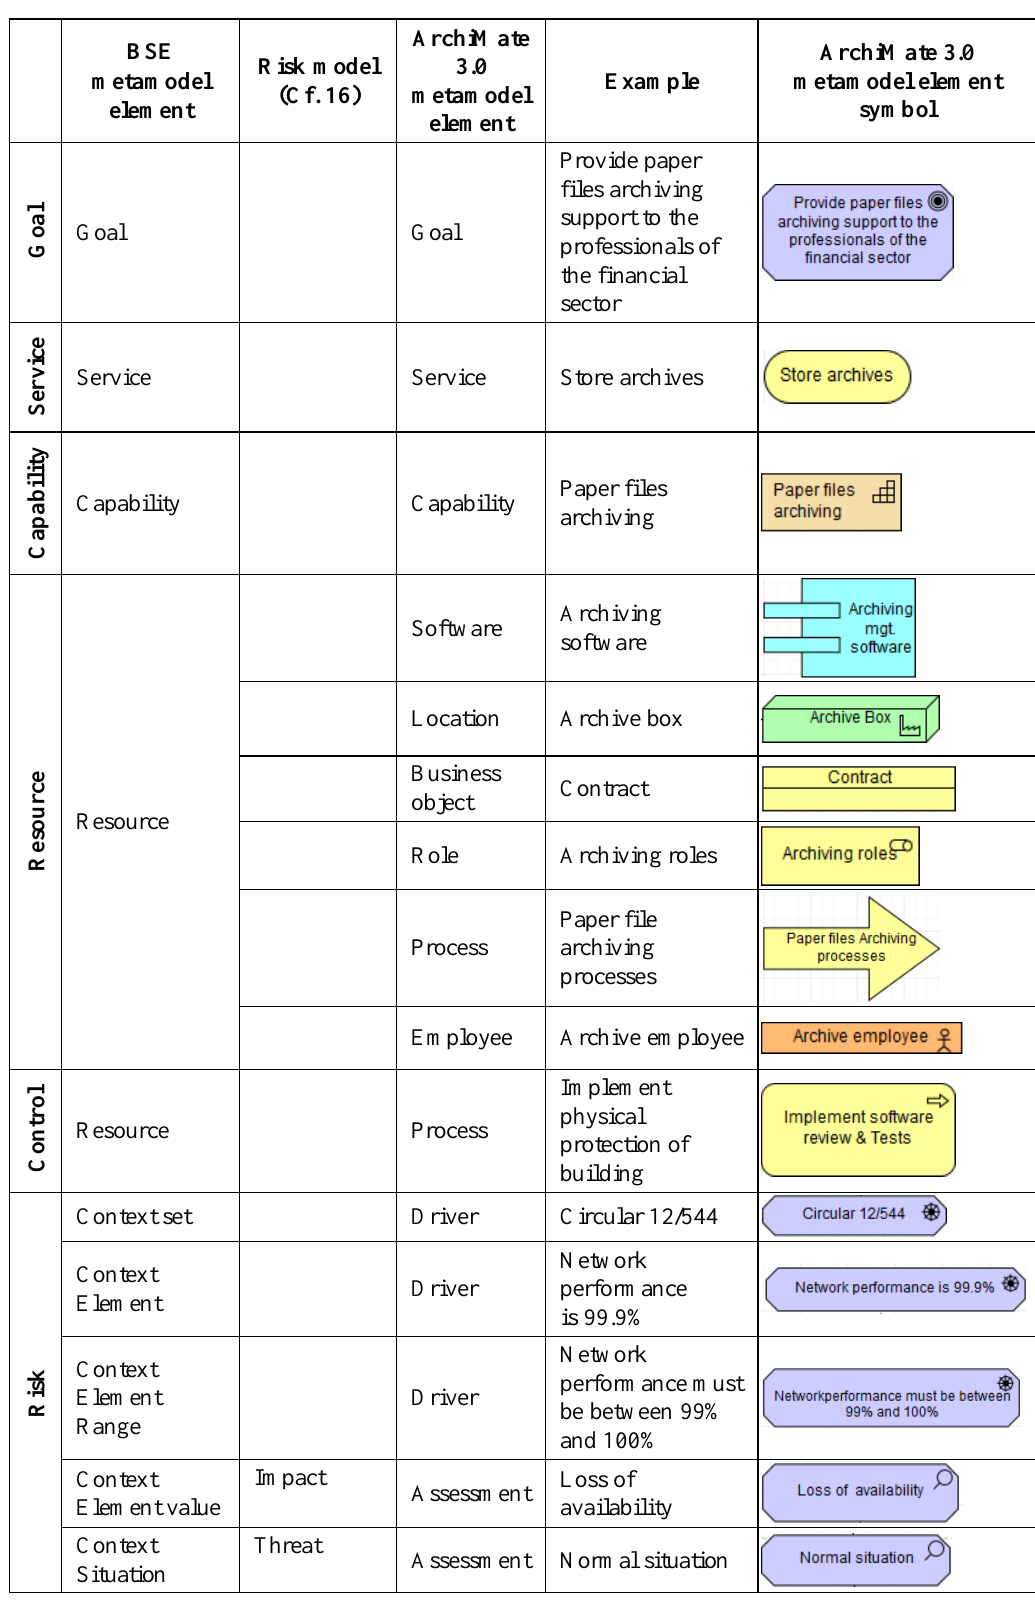
Table 1. BSE metamodel-ArchiMate 3.0 metamodel